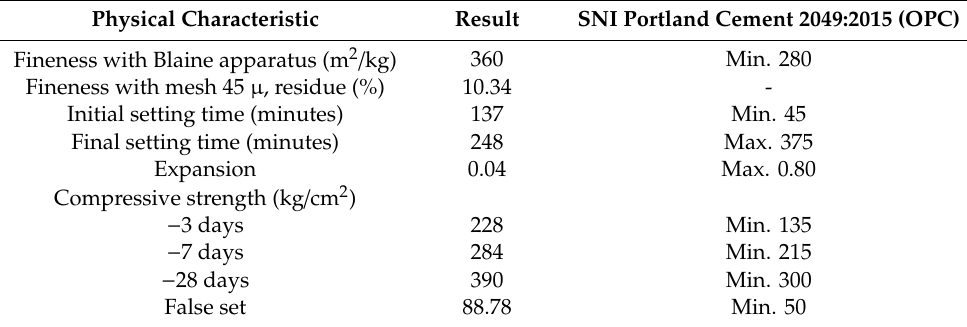
Table 2. Physical characteristics of ordinary Portland cement (OPC.